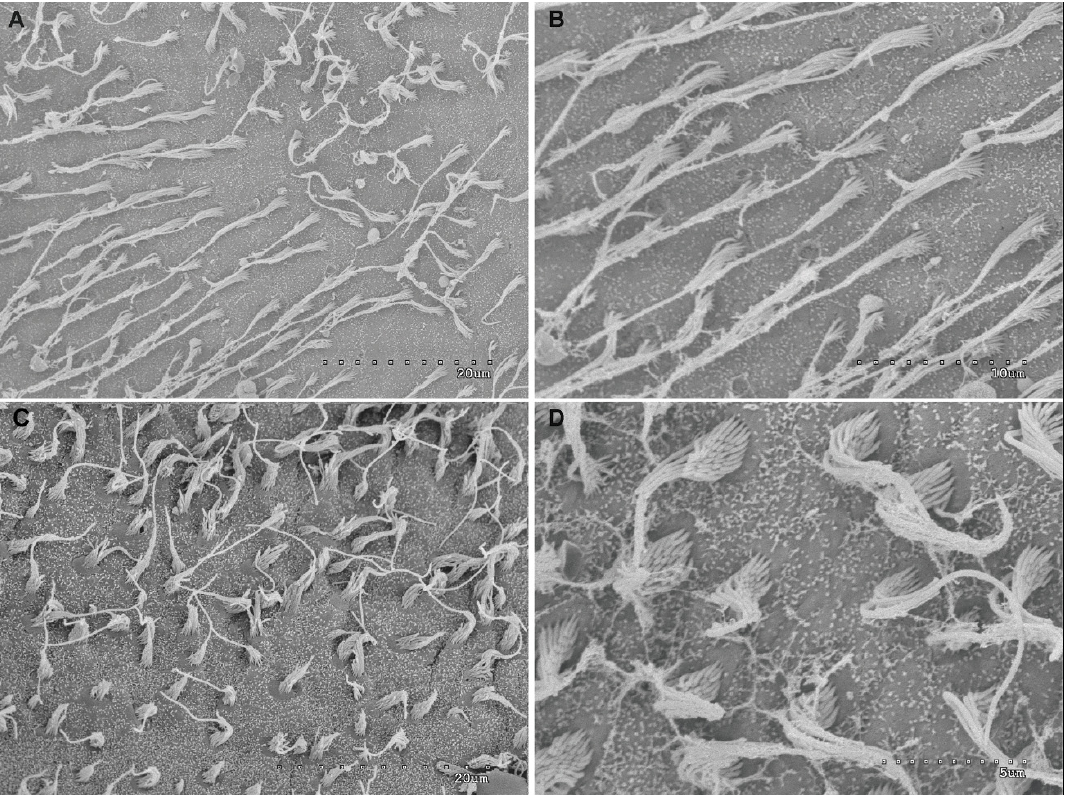
Figure 17. SEM. Salmon inner ear. Utricle sensory epithelium. ( A ) Control. ( B ) 3 weeks after sound exposure. ( C ) 6 weeks after sound exposure. ( D ) 12 weeks after sound exposure. By comparison with control animals, the images of the saccule epithelium show healthy sensory hair cells in all cases of exposed animals. Scale bar: ( A ) = 30 µm. ( B – D ) = 10 µm.